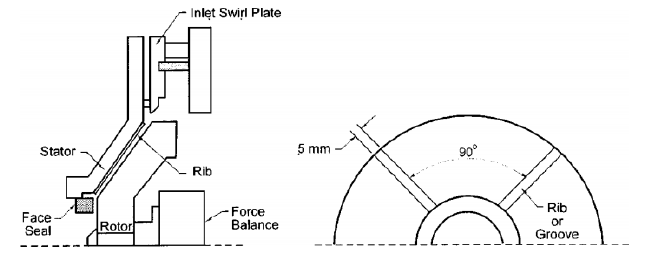
Figure 23. Swirl reduction devices. Reproduced from [145], ASME: